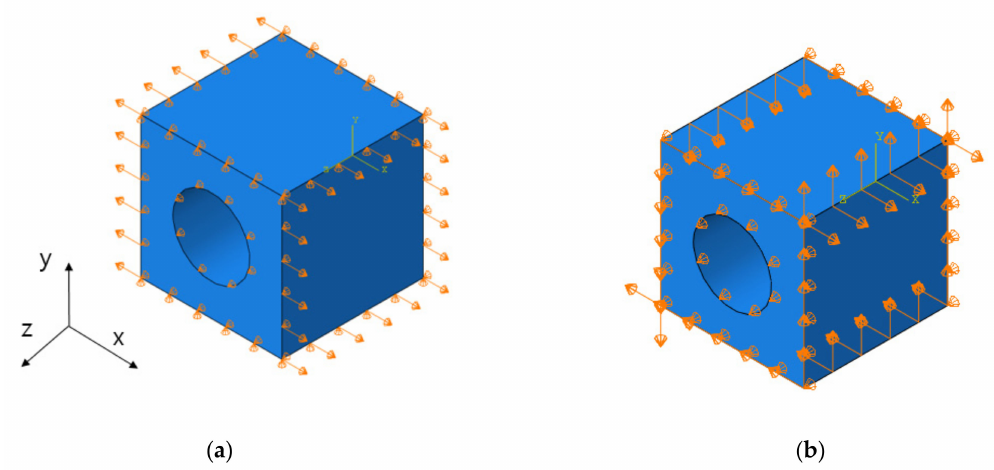
Figure 11. The boundary condition for strain. ( a ) X-direction tensile strain. ( b ) XY-direction shear strain.